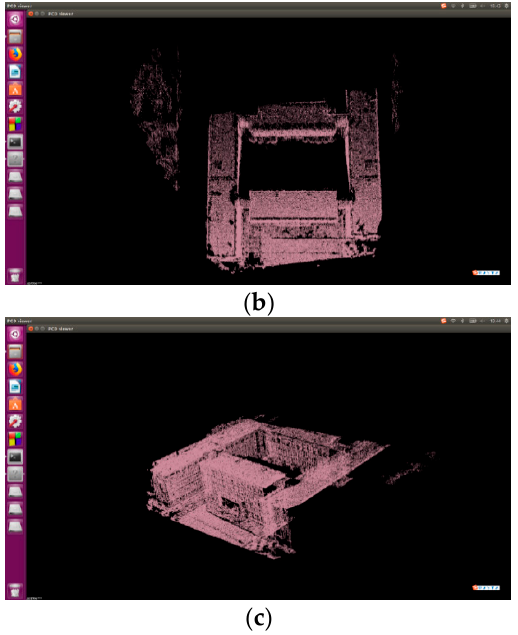
Figure 22. Resulting map of the 3D point cloud reconstruction experiment based on UAV platform. ( a ) Front view ( b ) Vertical view ( c ) Right-side view.